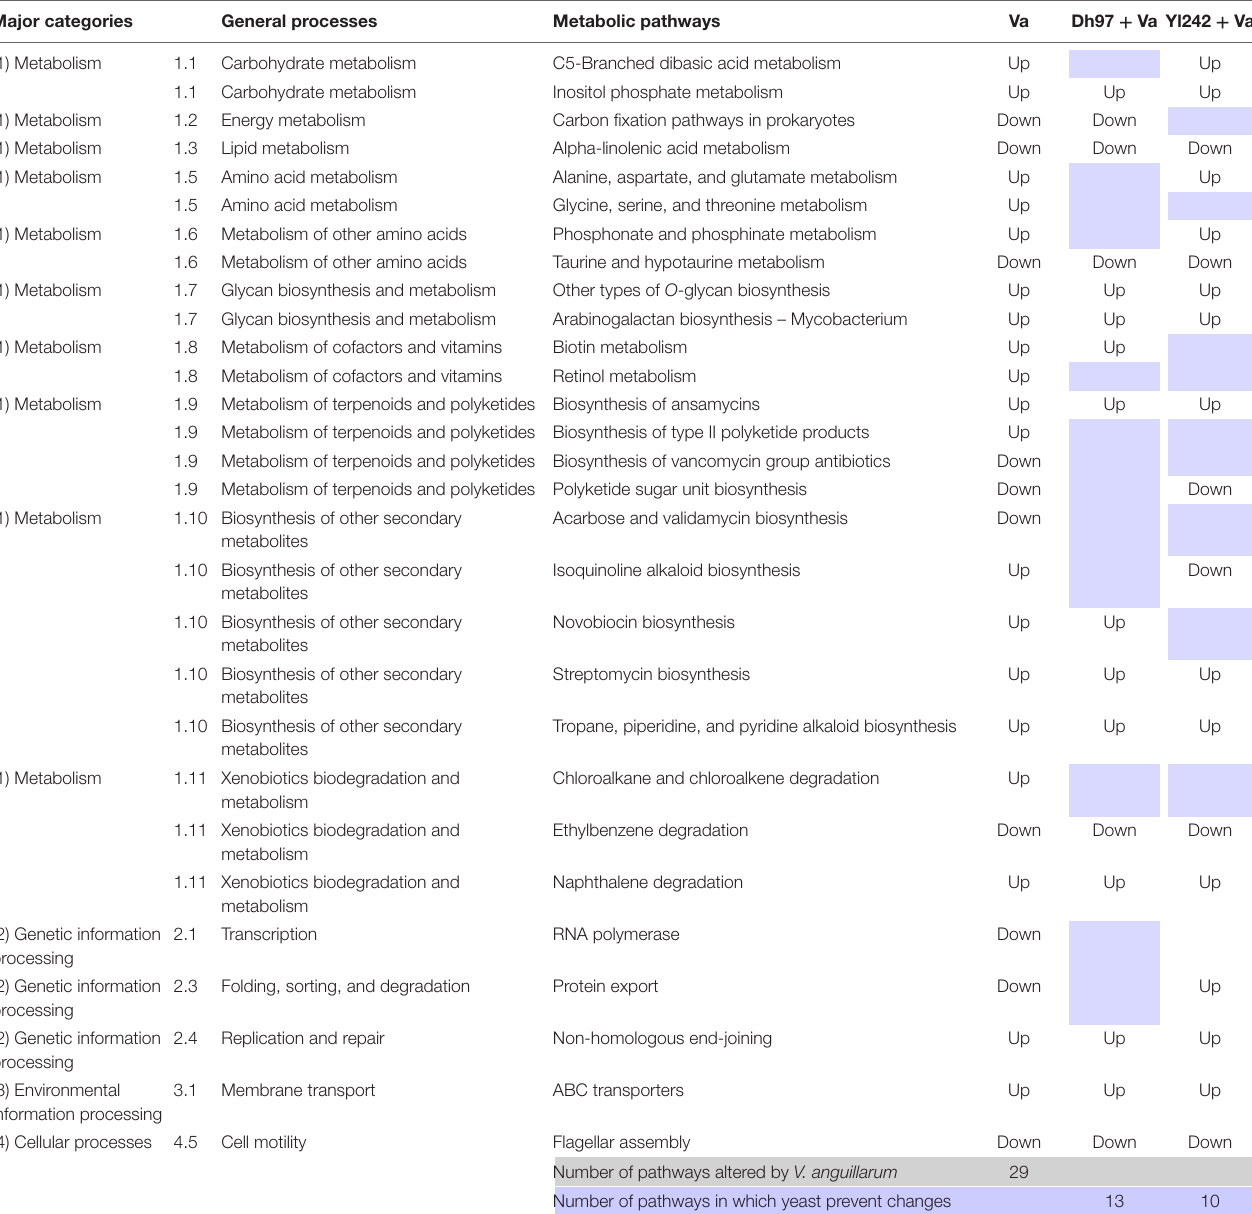
TABLE 1 | KEGG metabolic pathways inferred by 16S rRNA sequencing showing significant differences between Vibrio anguillarum infected group (Va) and the control group, and the effect of the pre-inoculation of infected larvae with yeasts (Dh97 + Va and Yl242 + Va group) over these altered pathways. Major